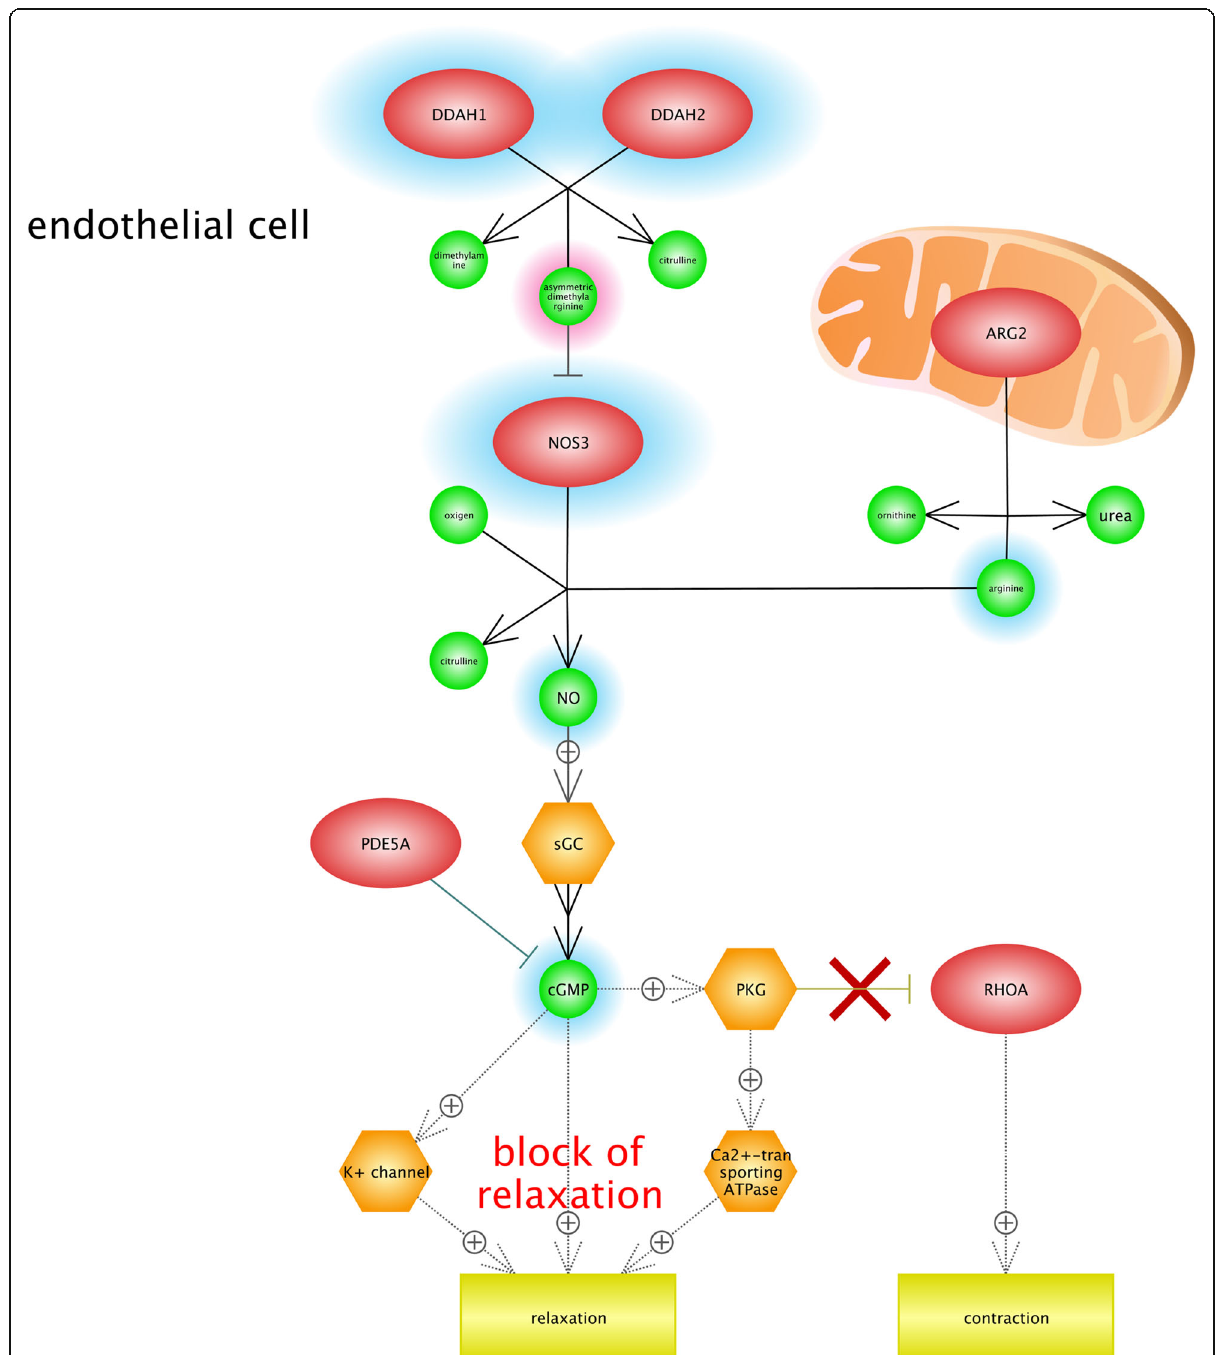
Fig. 8 Gene network analysis in order to identify the association between hypoxia condition and Raynaud disease (RD). According to our results, NO (nitric oxide) and ADMA (Asymmetric dimethylarginine) are considered as signaling pathways thatcontribute in RD. DDAH1 and DDAH2 are two isoforms of DDA that regulate the levels of ADMA in blood. Moreover, ADMA has a negative impact on endothelial-NO synthase 3 (NOS3) and is based on the dysfunction of endothelial cells associated with RD. It was observed that the ARG2 gene (Arginase-2), known as a mitochondria enzyme, contributes in the process of NO production in endothelia cells. The inhibition of NOS3 will lead to the low level of NO production; it can also lead to the increase of oxygen free radical formation and endothelial dysfunction. This figure highlights the importance of relaxation pathways ’ block. It has been demonstrated that stress and emotional upsets impact on the severity of the